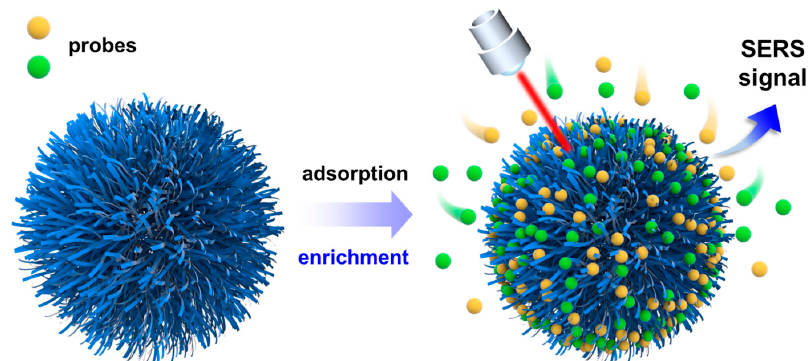
Figure 3. Possible SERS mechanism of CdSSe NFs-based system.